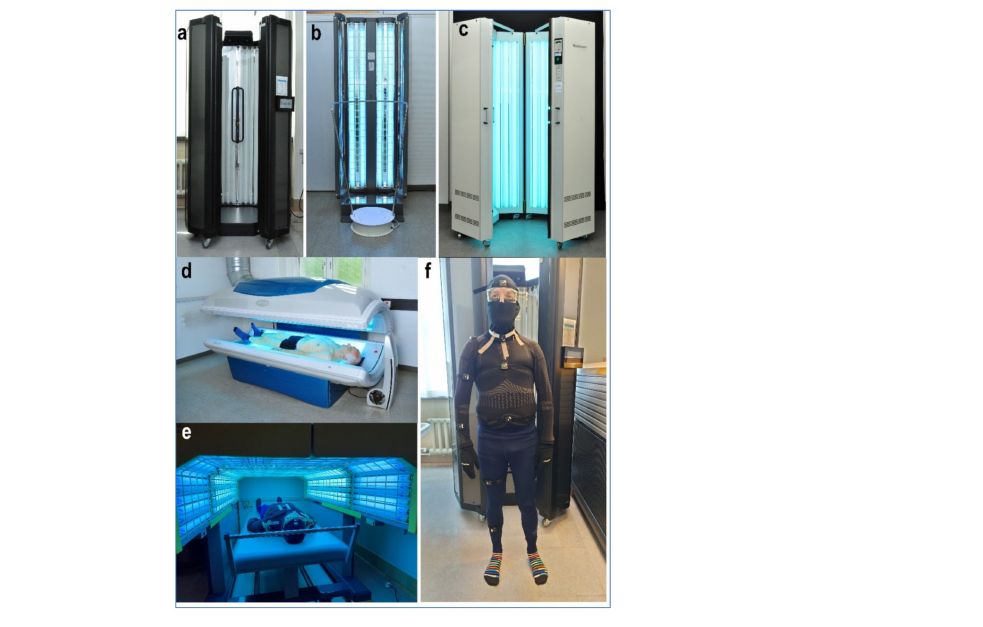
Figure 1. The five different treatment units ( a – e ) used in this study are described in the Methods section. A test person ( f ) covered in clothes with attached dosimeters and protective, yellow-tinted, UVR-absorbing PUVA eyewear was irradiated in all five treatment